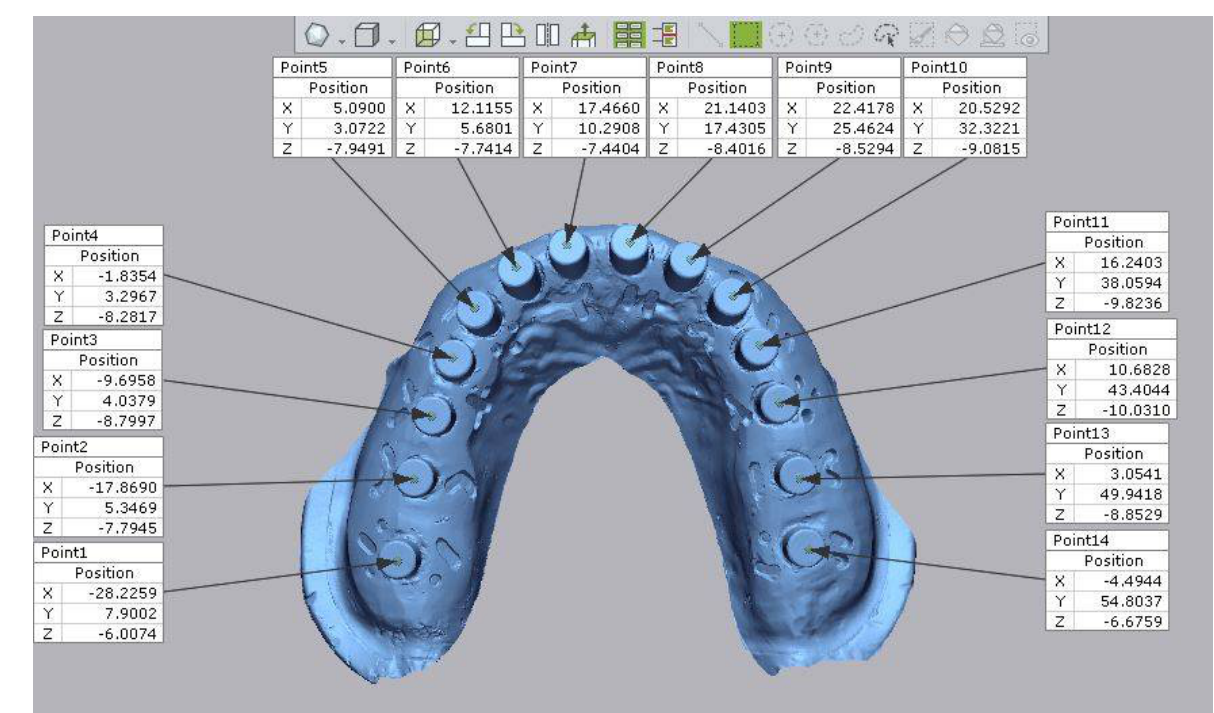
Figure 4. Measurements of the master model using a computerized coordinate measuring machine.